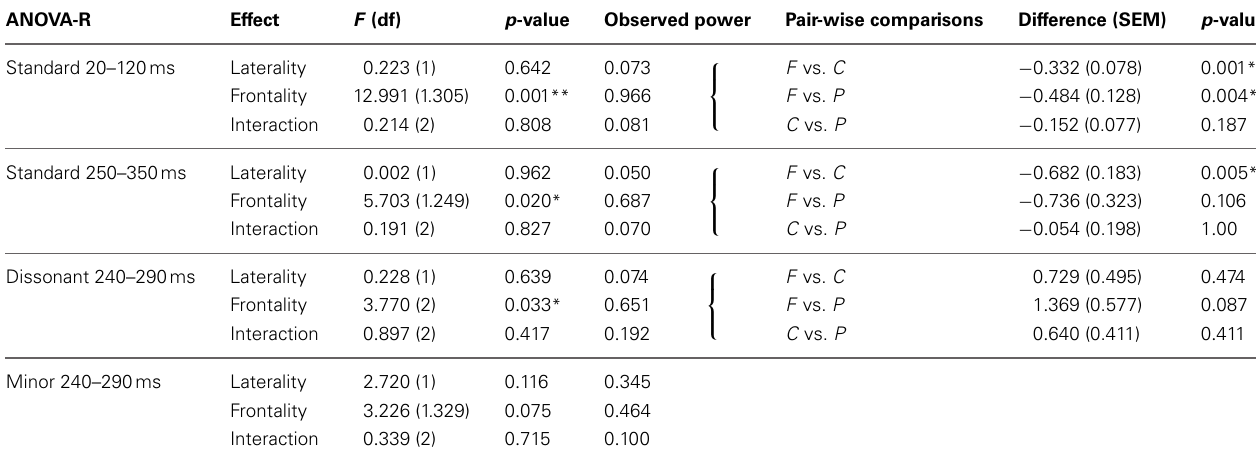
Table 4 | Results of the ANOVA-R showing F - and p -values for each response to laterality (left vs. right), frontality (frontal vs. central vs. parietal sites) and their interaction